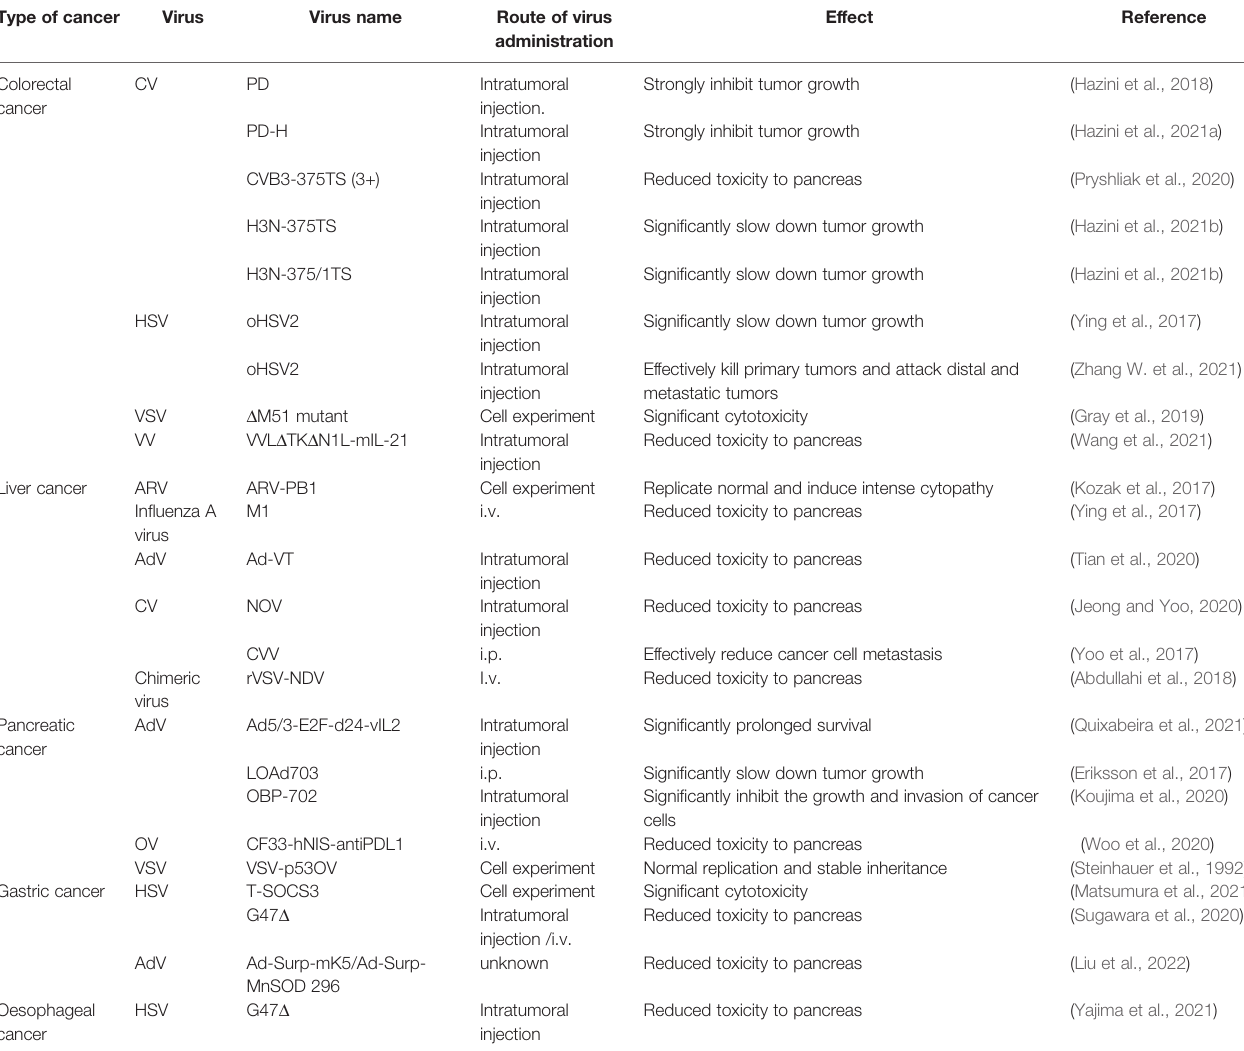
TABLE 1 | Oncolytic virus (including transgenic) monotherapy. Virus Virus